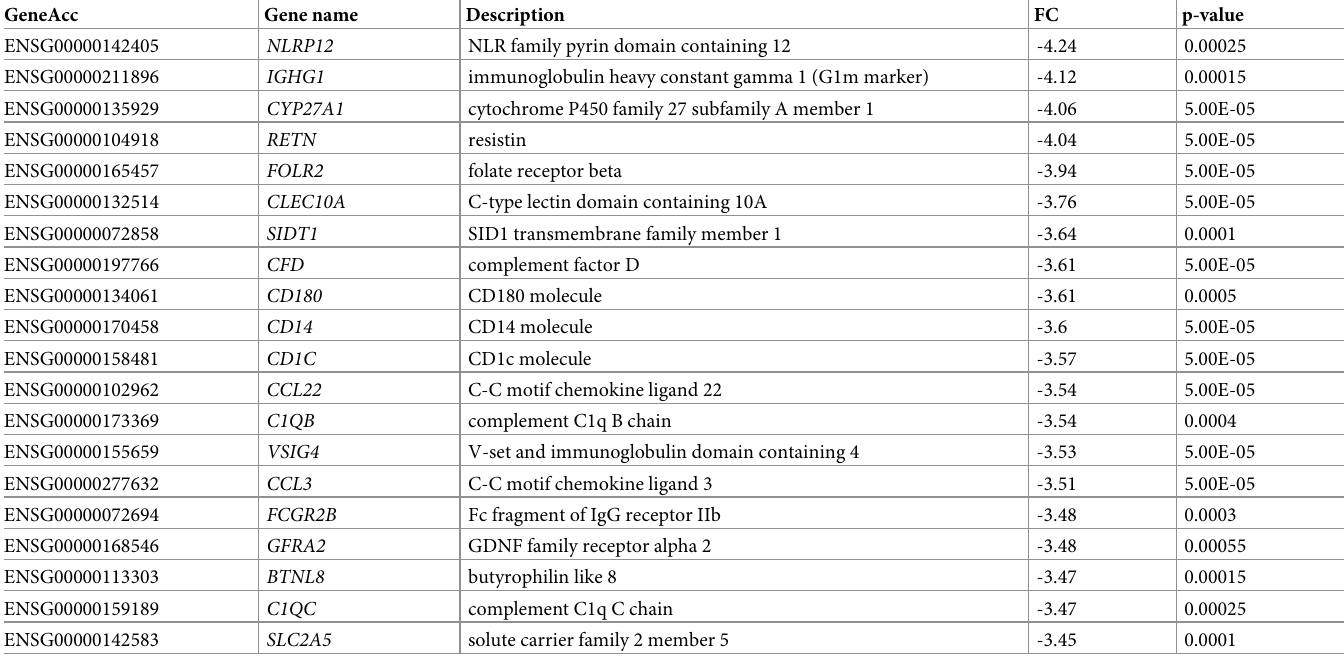
Table 3. Top 20 downregulated genes in the poor-quality embryo transfer group compared with the good-quality embryo transfer group.